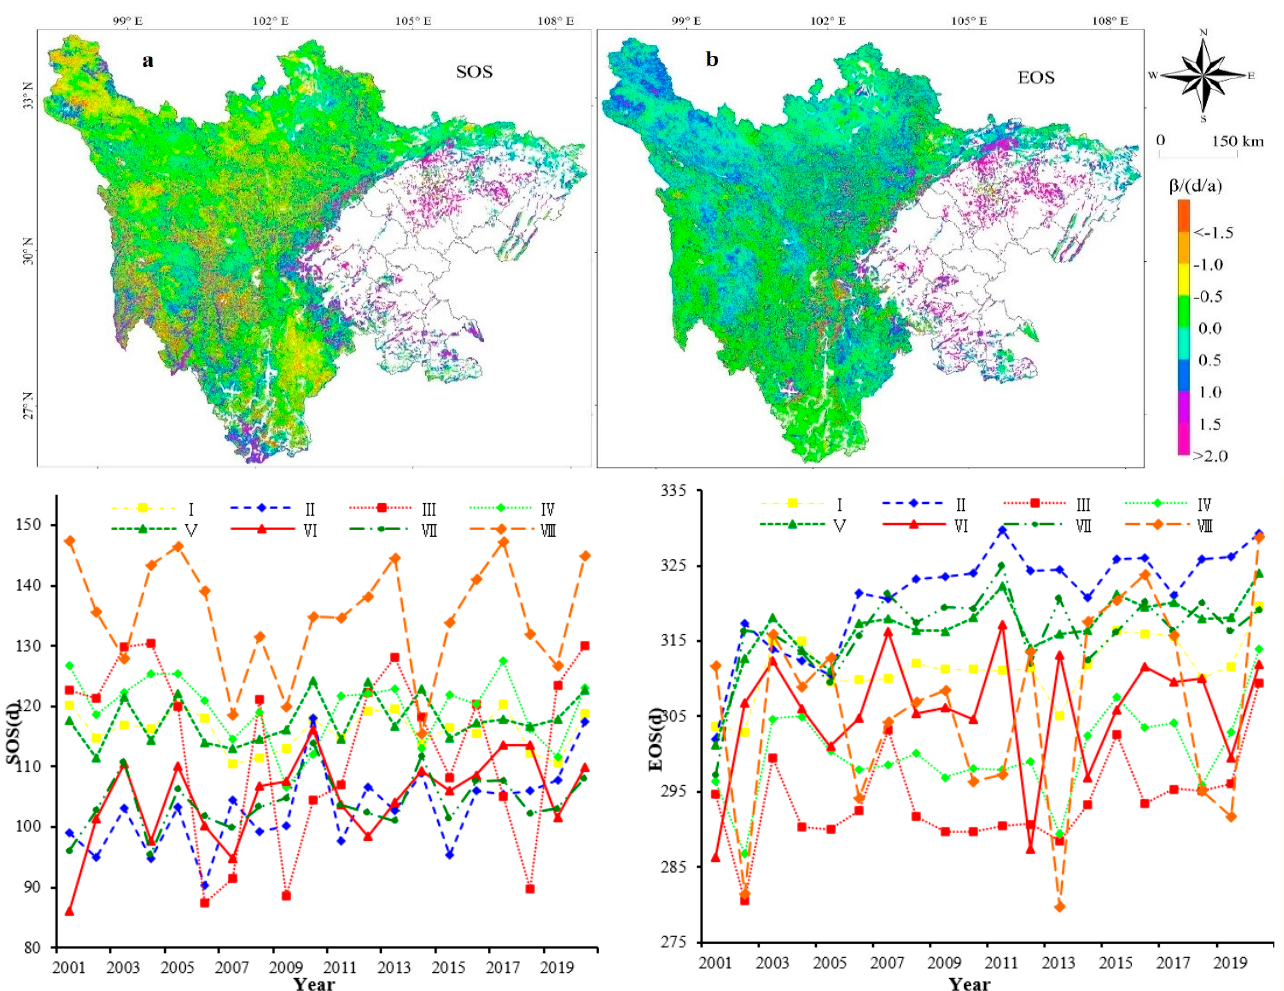
Figure 4. The trend of change in the spatial distribution of ( a ) grassland SOS, ( b ) grassland EOS, and the trend of interannual variation in vegetation phenology of SOS and EOS. ( Ⅰ : shrub; Ⅱ : steppe; Ⅲ : tussock; Ⅳ : meadow; Ⅴ : coniferous forest; Ⅵ : coniferous and broad-leaved mixed forest; Ⅶ : deciduous forest; Ⅷ : alpine vegetation).